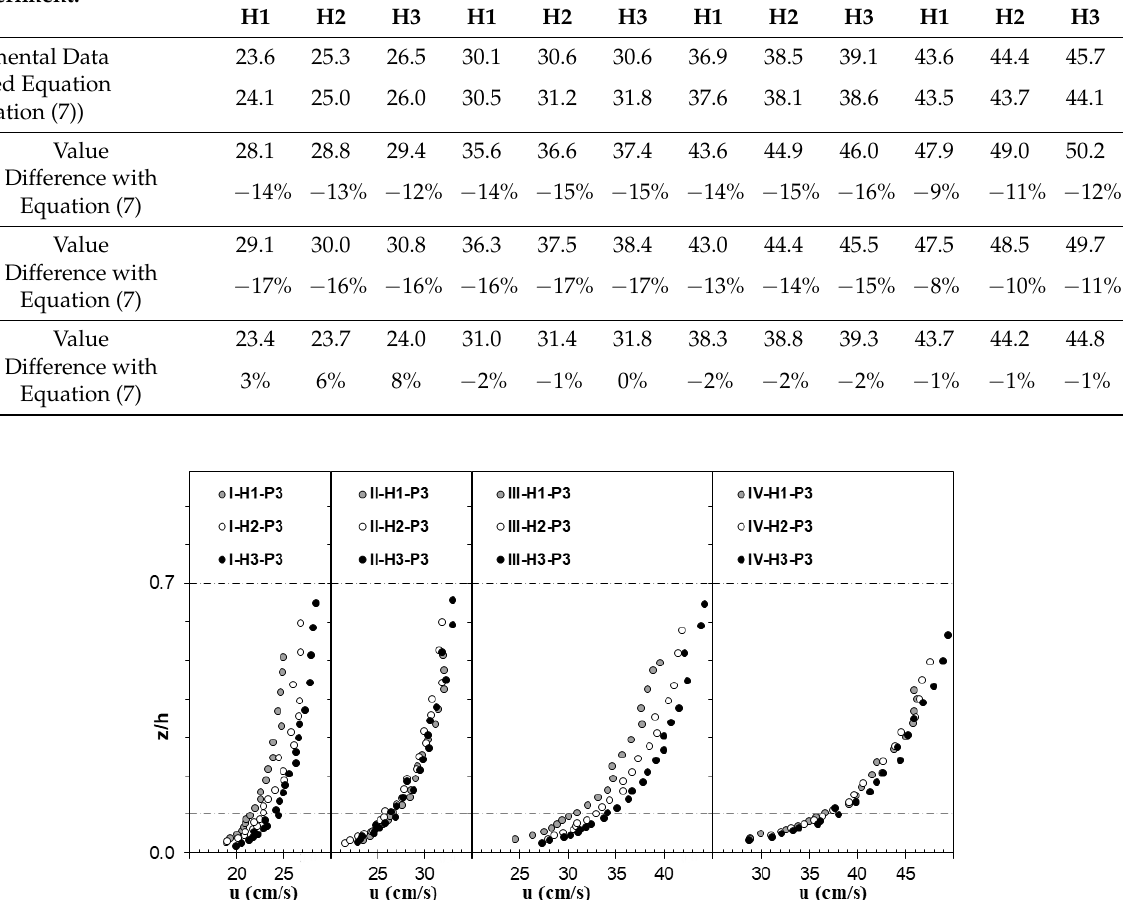
Figure 7. Flow velocity distribution under threshold conditions